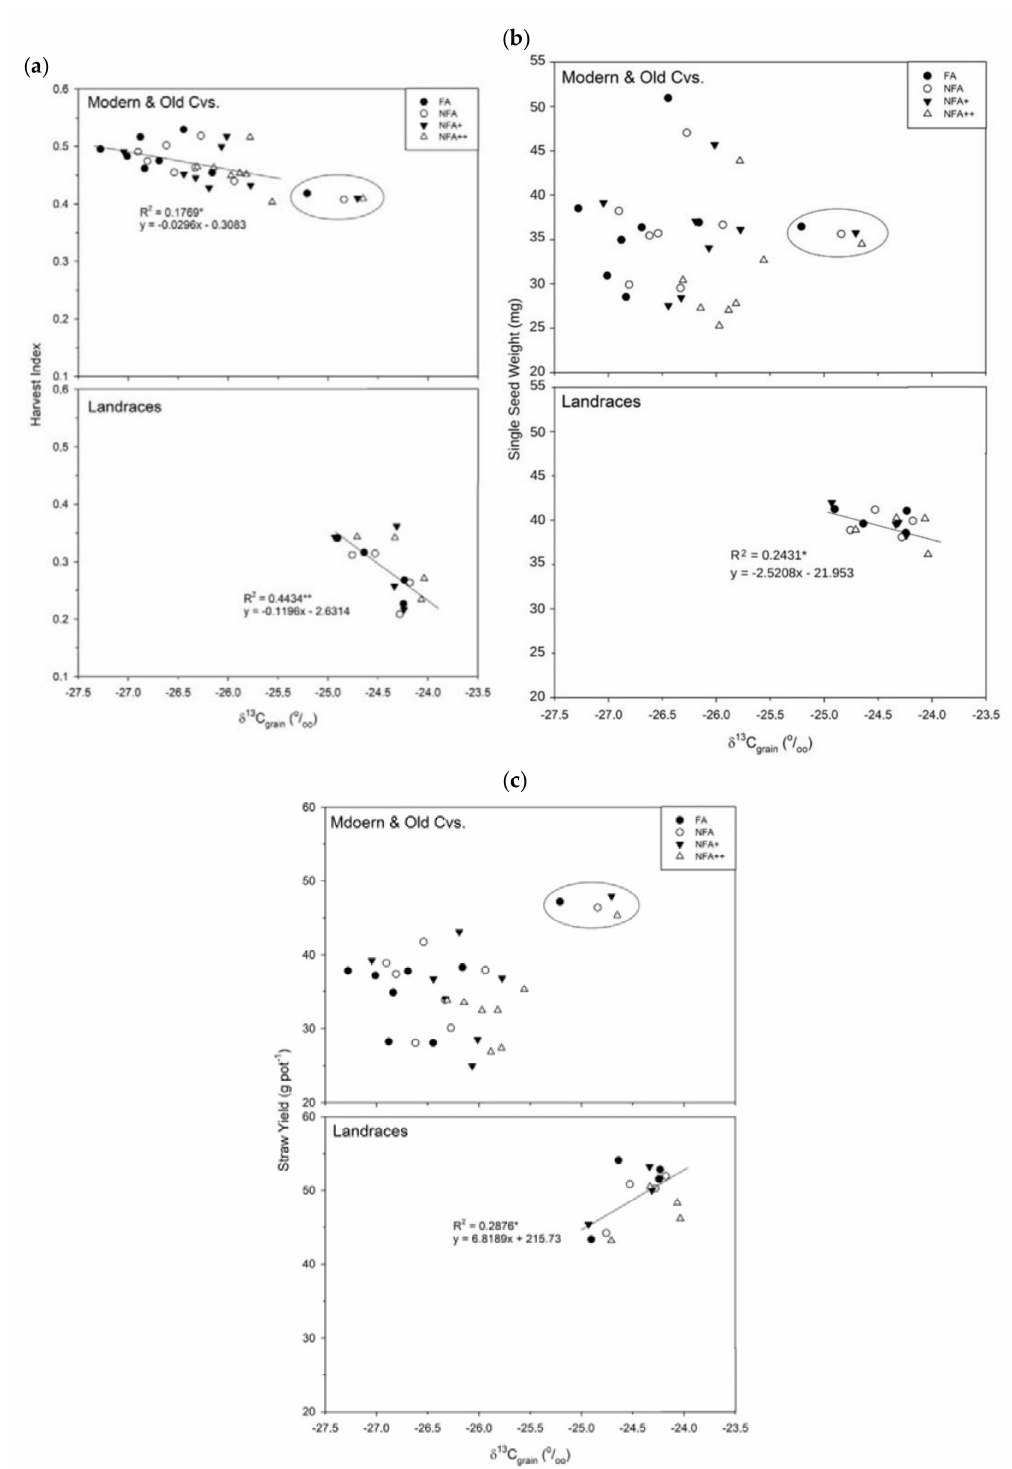
Figure A1. Regression functions of δ 13 C (stable C isotope composition, ‰) with: ( a ) Harvest Index, ( b ) Single seed weight (mg) and ( c ) Straw yield (g pot − 1 ) for the different O 3 -treatments: FA= charcoal filtered air, NFA = non-filtered air, NFA+ = non-filtered air supplemented with 20 nL L − 1 of O 3 , NFA++ = non filtered air supplemented with 40 nL L − 1 of O 3 . Circle encloses Pane 247—Old CV, not considered for correlation analyses. Correlation is significant at ** p ≤ 0.01 or * p ≤